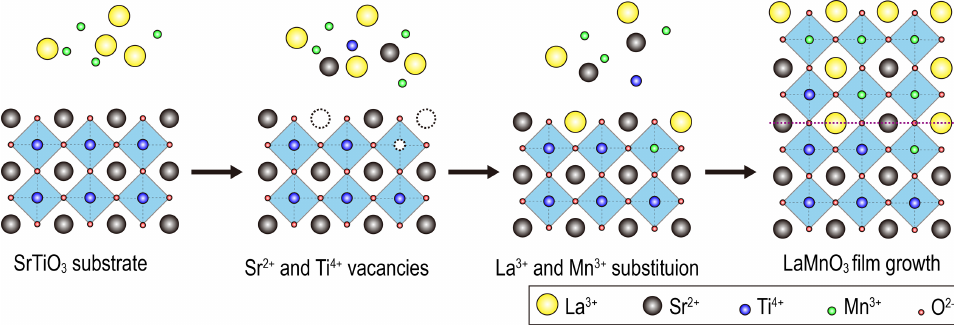
Figure 9. Schematic view of LaMnO 3 epitaxial thin film growth mechanism.